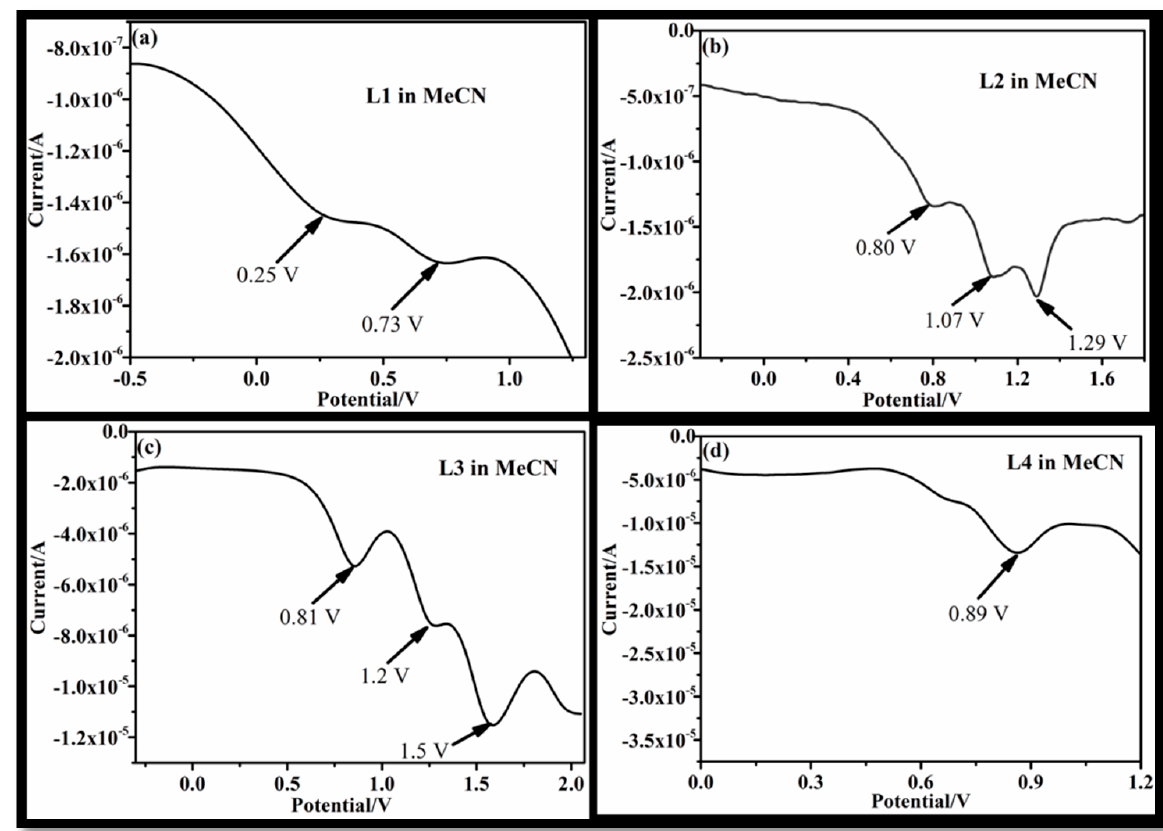
Figure 1. Anodic voltammogram of receptor L1 ( a ), L2 ( b ), L3 ( c ), and L4 ( d ) in MeCN medium.